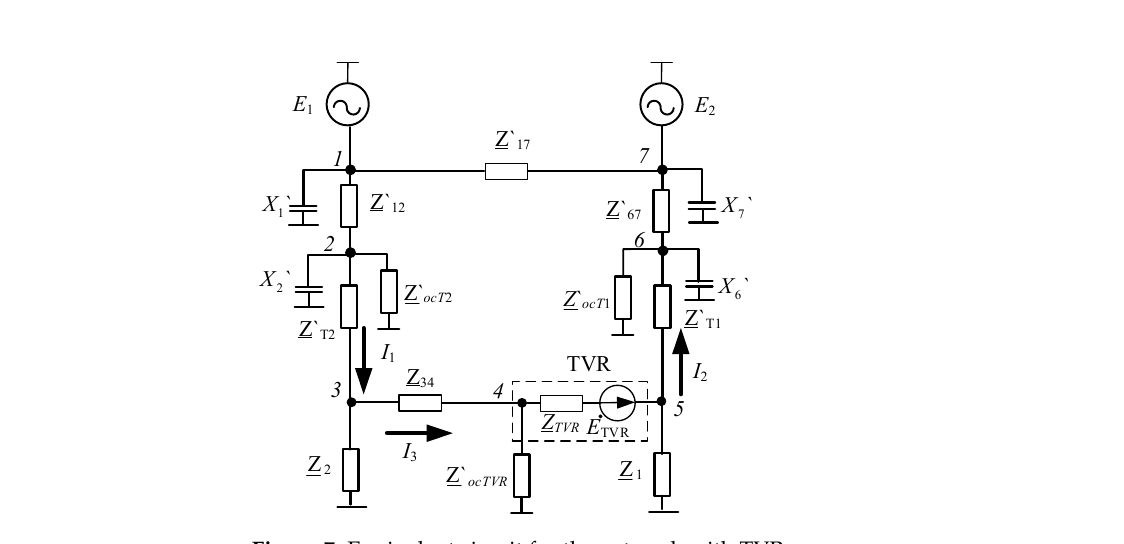
Figure 7. Equivalent circuit for the network with TVR. Table 1. Power transmission lines data.